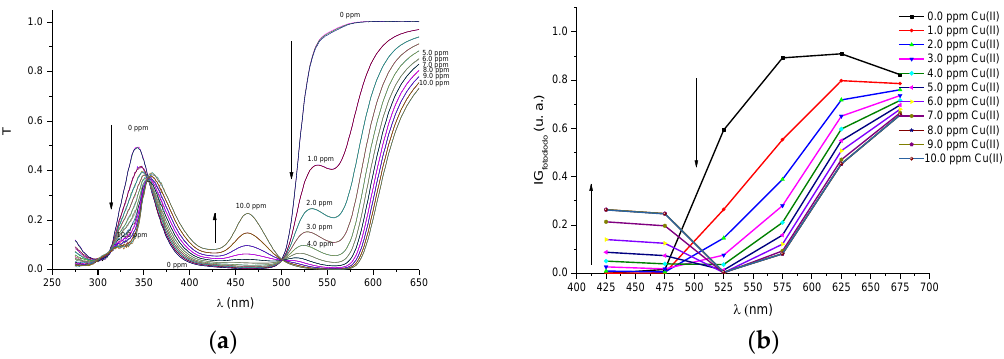
Figure A4. The transmittance spectra of the chromogen reagent of 1-(2-pyridylazo)-2-naphthol (PAN) solution containing Cu(II) ions at different concentrations corresponding to: ( a ) The UV-VIS Cary ® 50-Varian spectrometer ( b ) the multiespectral MMCS6CS sensor.